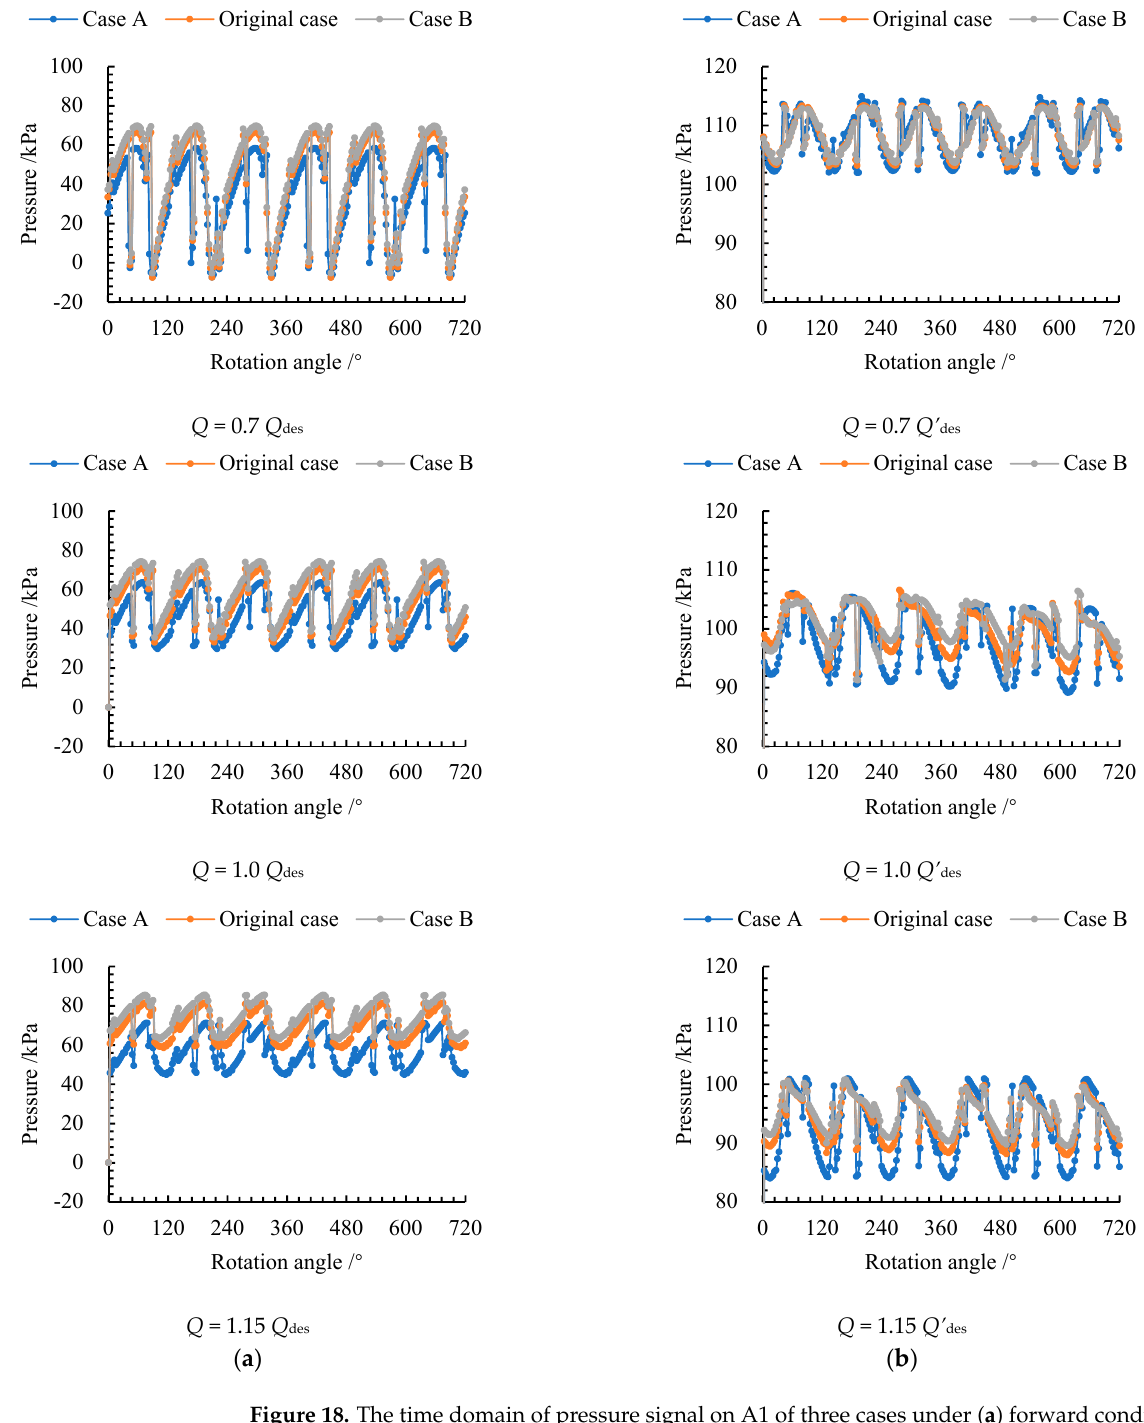
Figure 18. The time domain of pressure signal on A1 of three cases under ( a ) forward condition and ( b ) reverse condition.